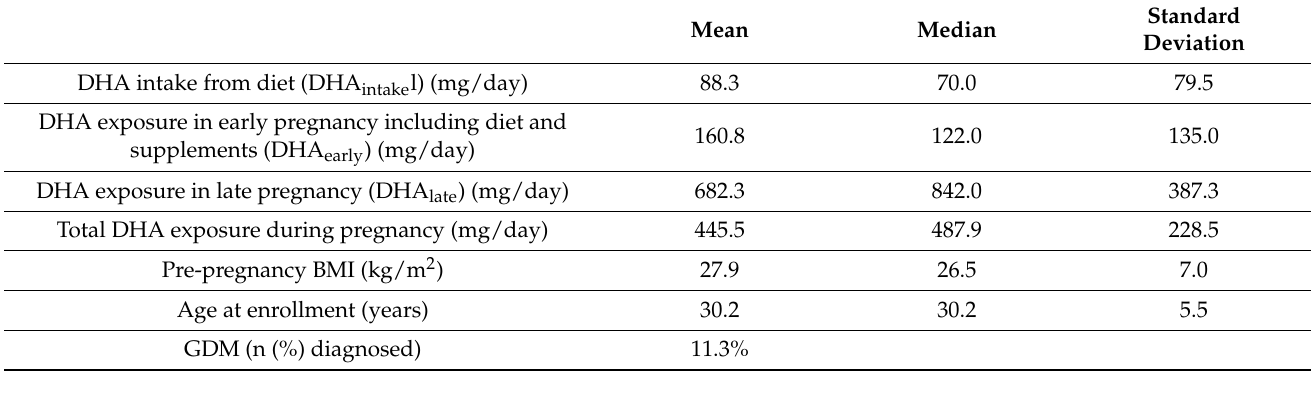
Table 1. Summary Statistics (mean, median, and standard deviation for all variables).